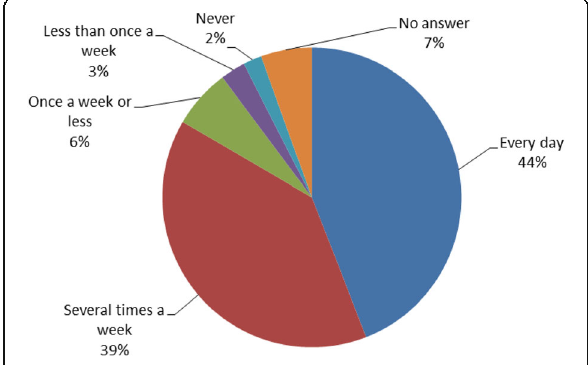
Fig. 3 The percentage division of children depending on the frequency of their breakfast consumption